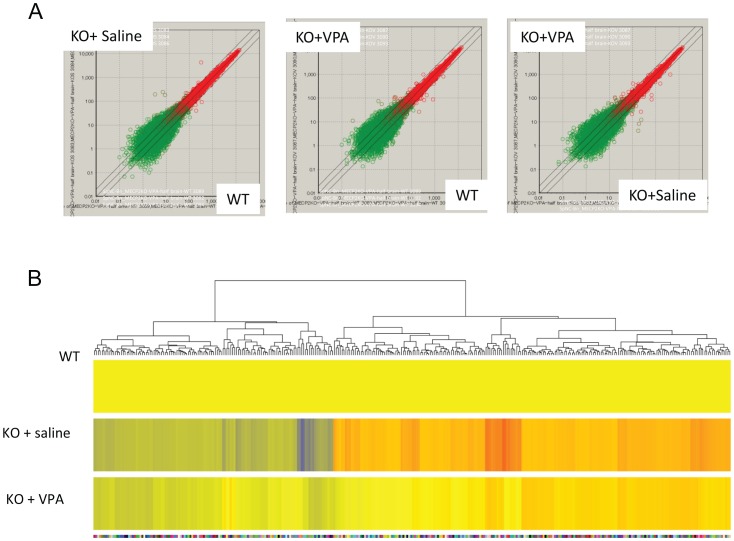
VPA treatment restores the expression of a subset of genes in MeCP2 KO brains.(A) Scatter plots showing differential gene expression profiles among experimental conditions. (B) Heatmap showing 33 genes with >1.2-fold changes in the MeCP2 KO compared to WT brains and that were restored to <1.2-fold changes upon VPA treatment.